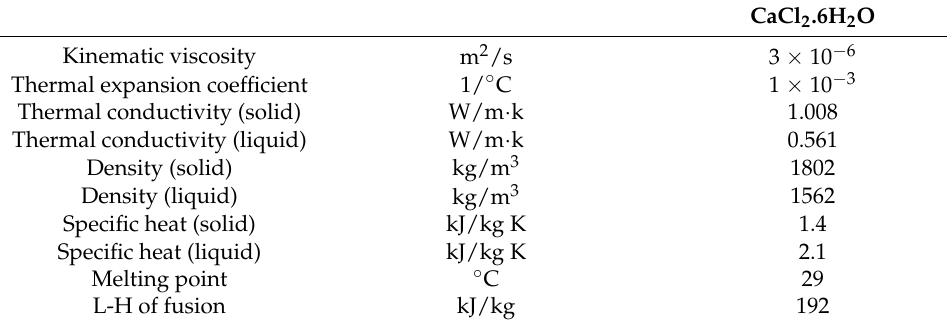
Table 2. Properties of PCM used in the present study.